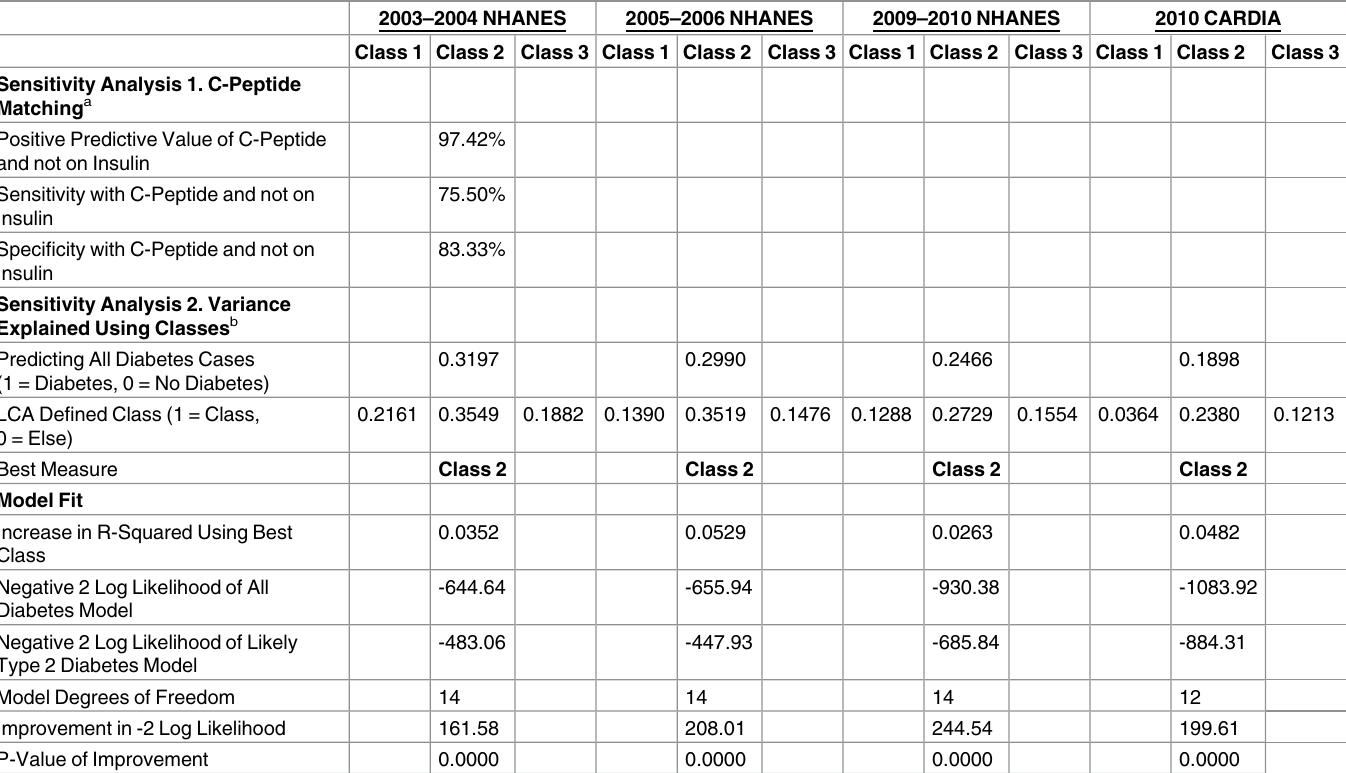
Table 3. Sensitivity analysesusing C-peptide matching and increased